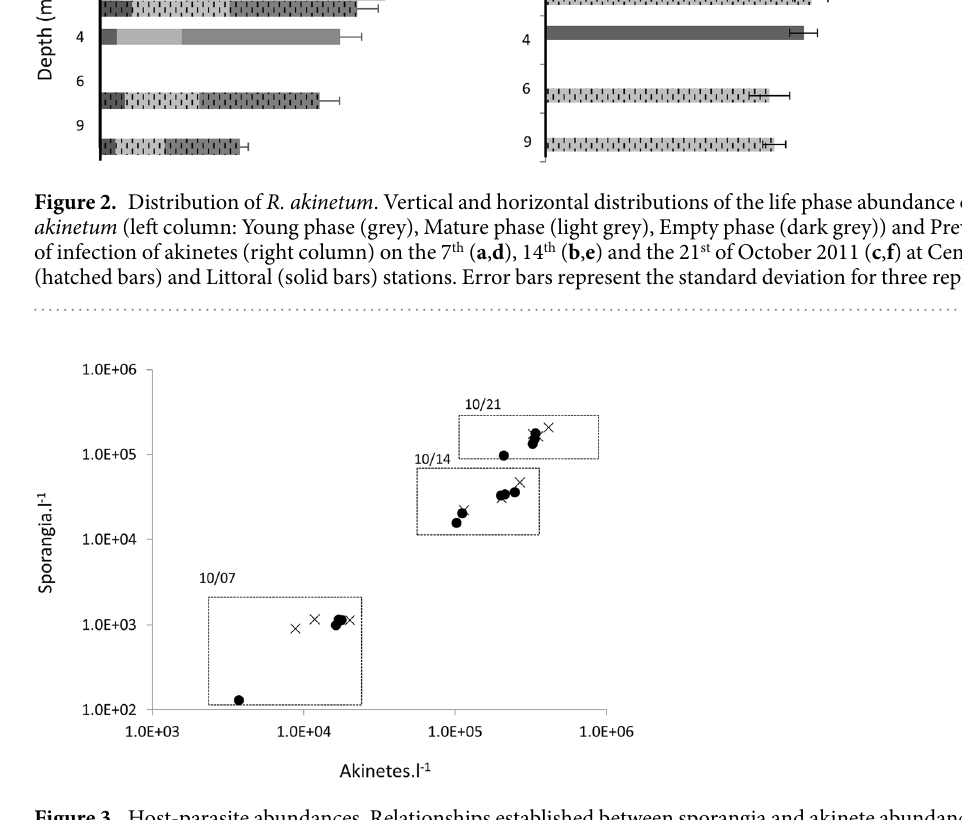
Figure 3. Host-parasite abundances. Relationships established between sporangia and akinete abundances at Central (circles) and Littoral (cross) stations on the 7 th , 14 th and 21 st of October